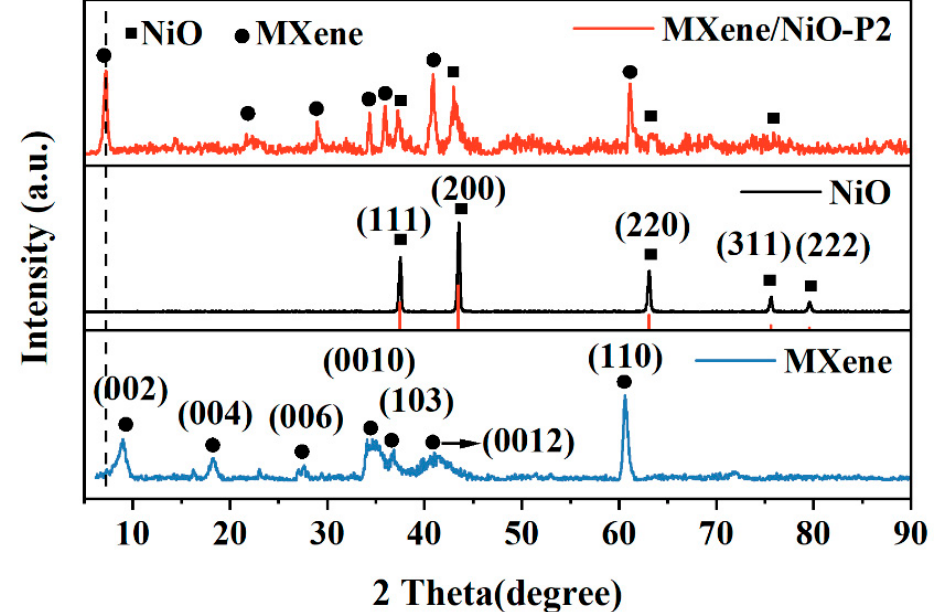
Figure 2. XRD patterns of MXene, NiO, and Figure 2. XRD pa tt erns of MXene, NiO, and MXene/NiO-P2.